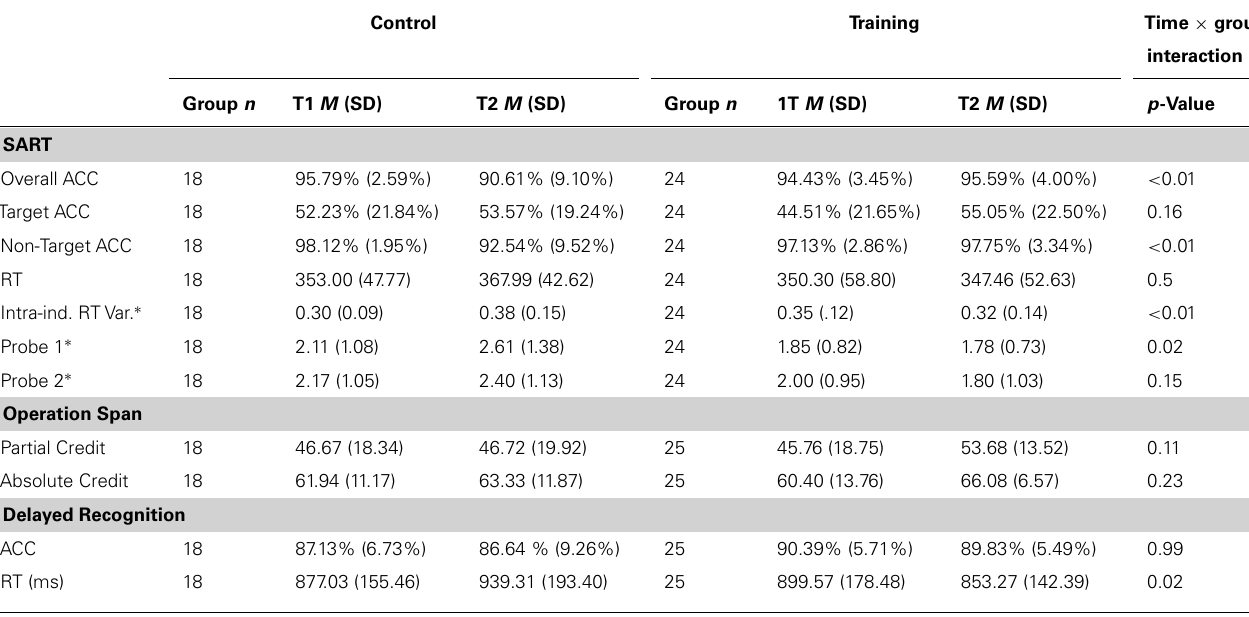
Table 1 | Cognitive performance prior to and following the 7 week training